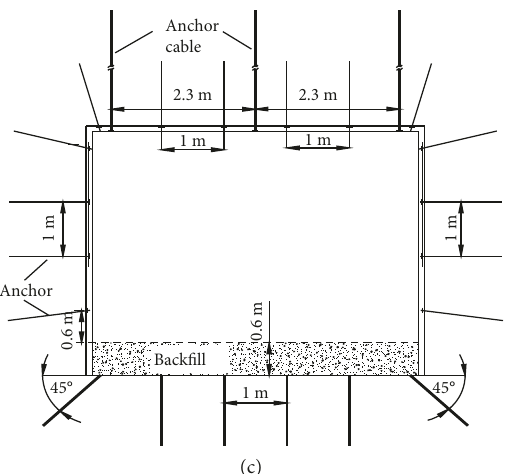
Figure 17: Roadway support parameter optimization design diagram. (a) Overbreaking. (b) Bolting and grouting (c) Backfill.